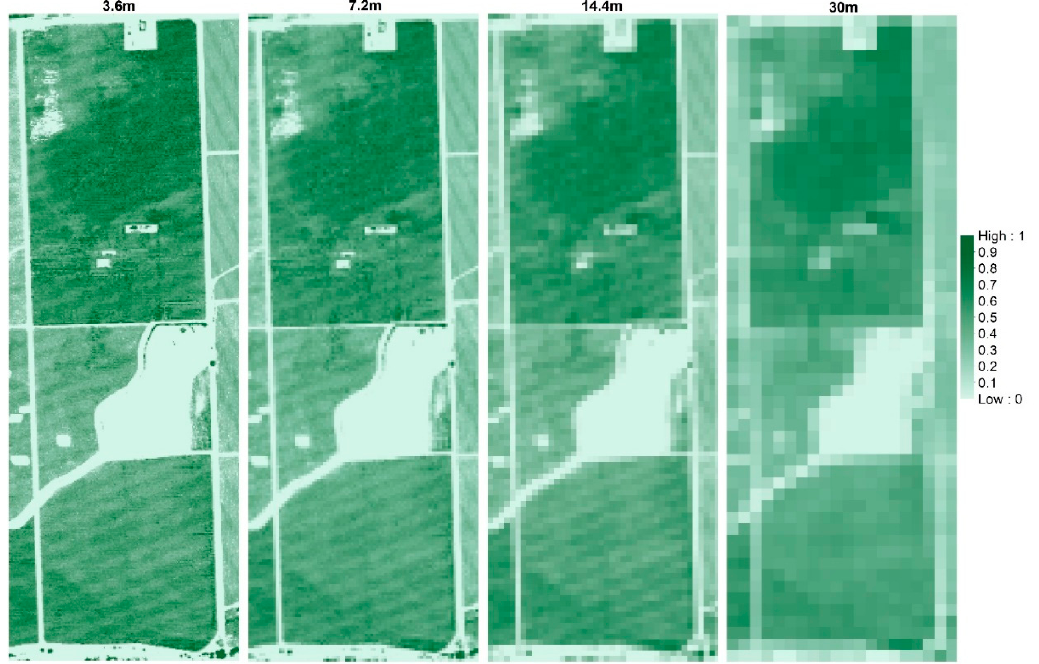
Figure A2. Example of modeled f c across different spatial domains for 09 August 2014.